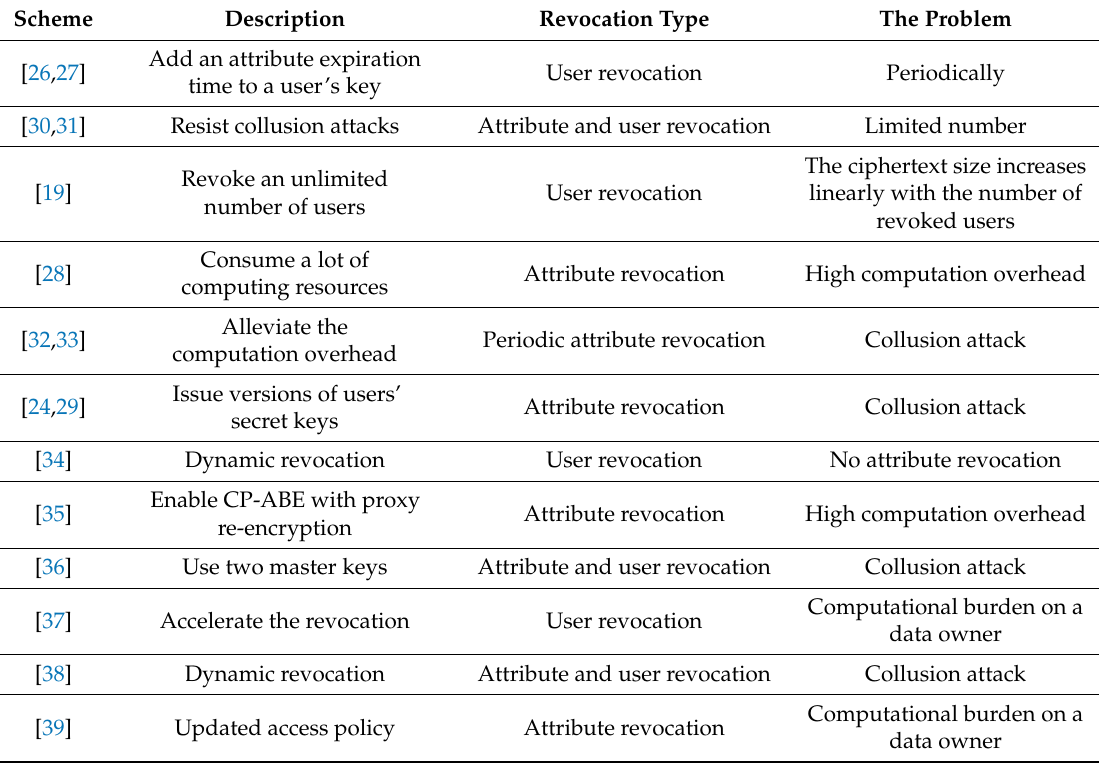
Table 2. Classifying main existing systems based on the revocation